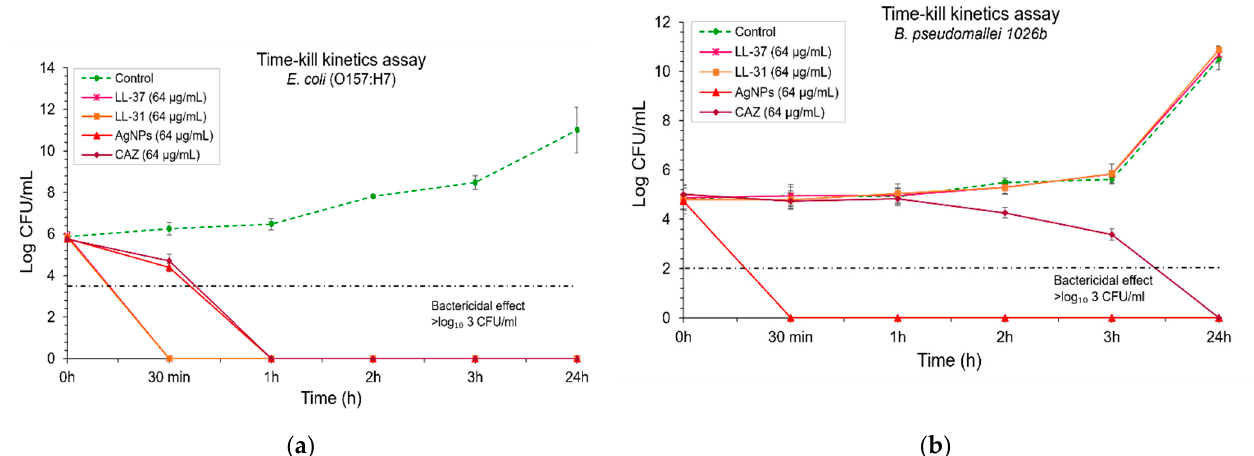
Figure 4. Time-kill kinetics assay of antibacterial agents (LL-37, LL-31, AgNPs and ceftazidime used as a positive control): ( a ) against E. coli O157: H7; ( b ) and B. pseudomallei 1026b. Bacterial suspensions were incubated with each antibacterial agent at a final concentration of 64 µg/ml at time points of 0, 0.5, 1, 2, 3, and 24 h. The bactericidal effect was defined as ≥ 3 log ₁₀ CFU/mL compared with untreated control. Data represent mean value ± SD (error bar) from two independent experiments carried out in triplicate ( n = 6).